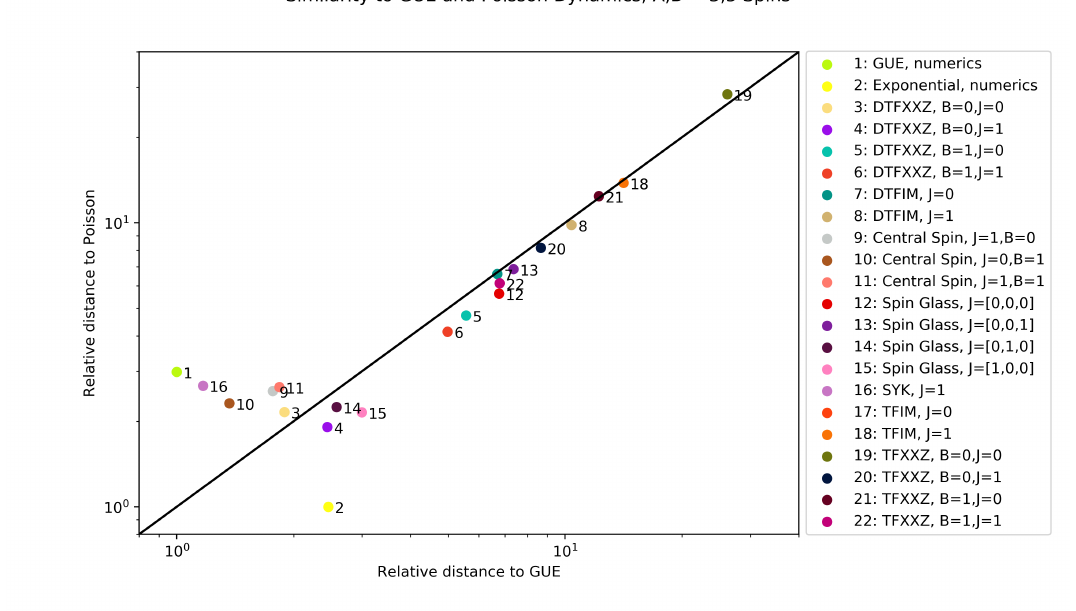
Figure 19: Relative distance of dynamics, in the sense of equation 51 of various models to the GUE and Poisson ensembles. Note that by our normalization the horizontal coordinate of the GUE ensemble must be unit, as well as the vertical of the Exponential. The closer another model approaches these points, the better its dynamics are approximated by the theory in this